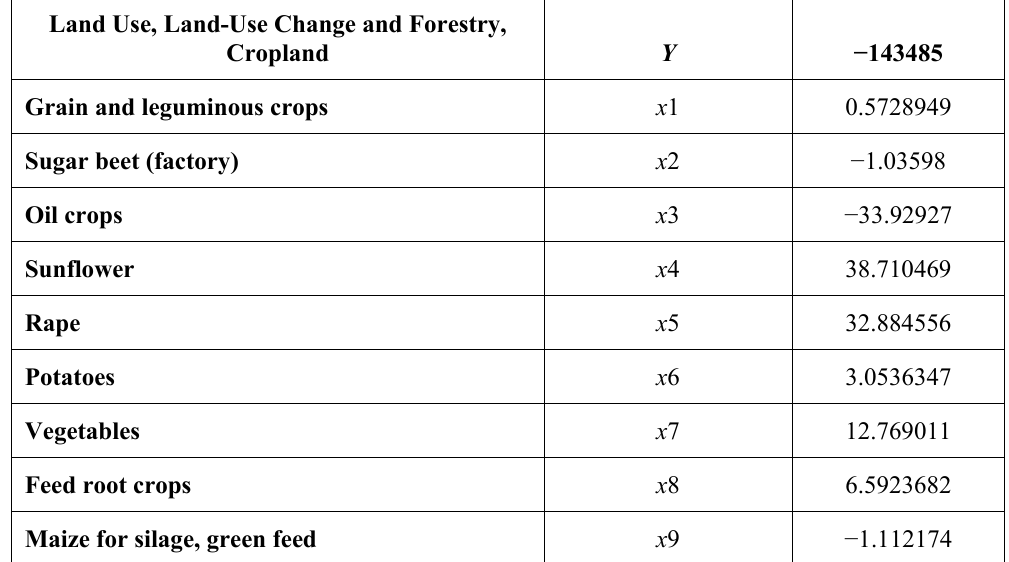
Table 4. Correlation Analysis